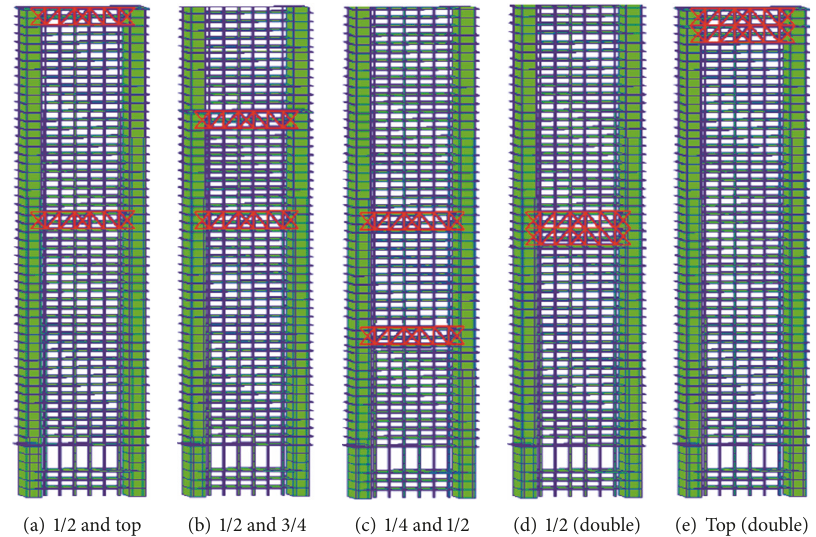
Figure 11: Schematic representation of the position of the belt trusses for Case 1: see Table 8.